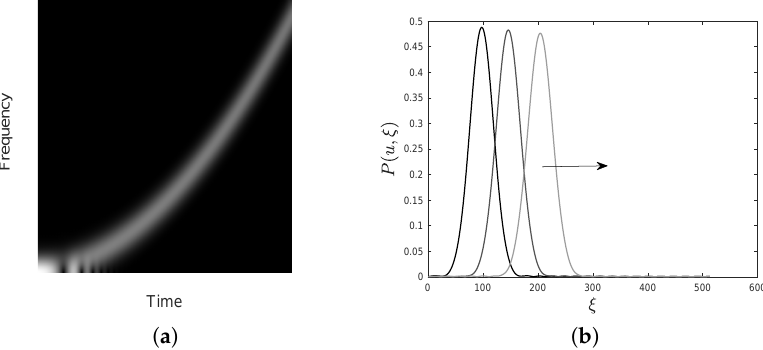
Figure 3. ( a ) Spectrogram of an FM signal. ( b ) Spectrogram sections for increasing u . The arrow indicates the direction of the